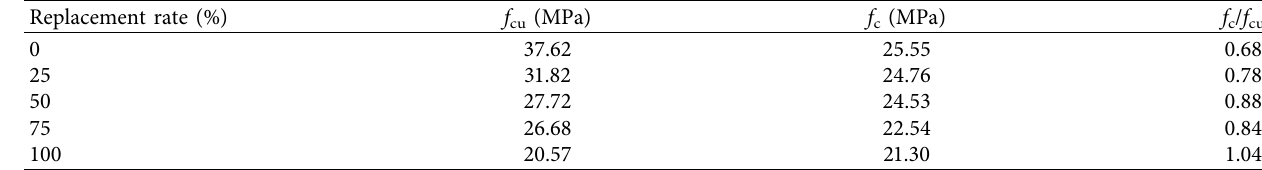
Table 2: Compressive performance of recycled lightweight aggregate concrete.